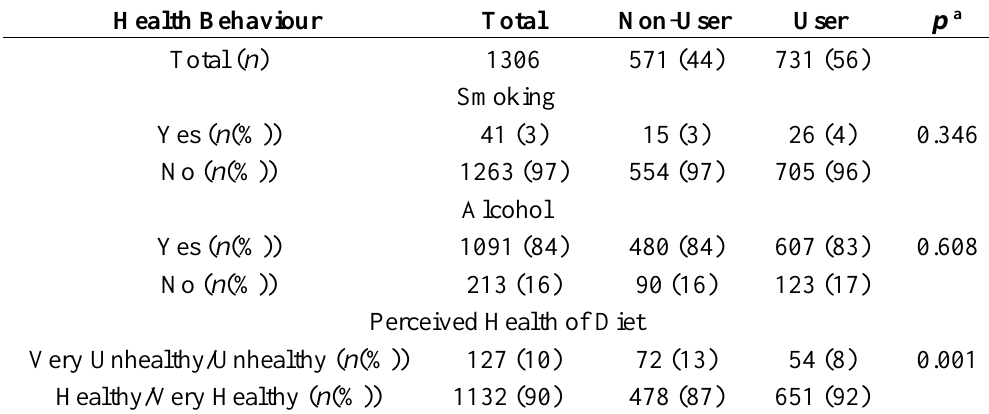
Table 2. Health behaviour characteristics of participants and their association with supplement